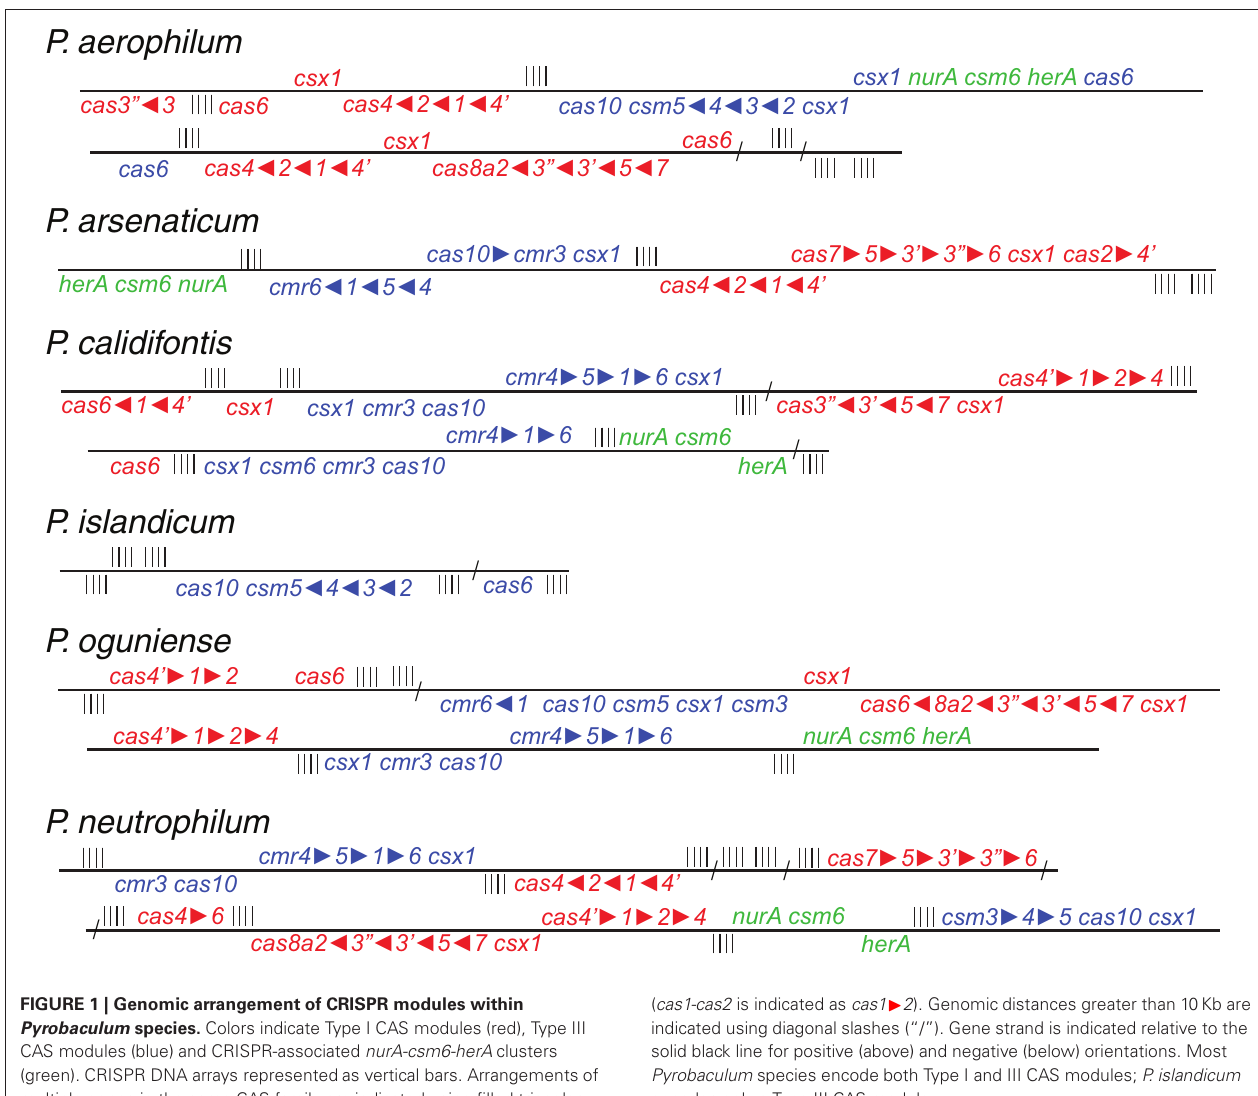
( cas1-cas2 is indicated as cas1 (cid:2) 2 ). Genomic distances greater than 10Kb are indicated using diagonal slashes (“/”). Gene strand is indicated relative to the solid black line for positive (above) and negative (below) orientations. Most Pyrobaculum species encode both Type I and III CAS modules; P. islandicum encodes only a Type III CAS